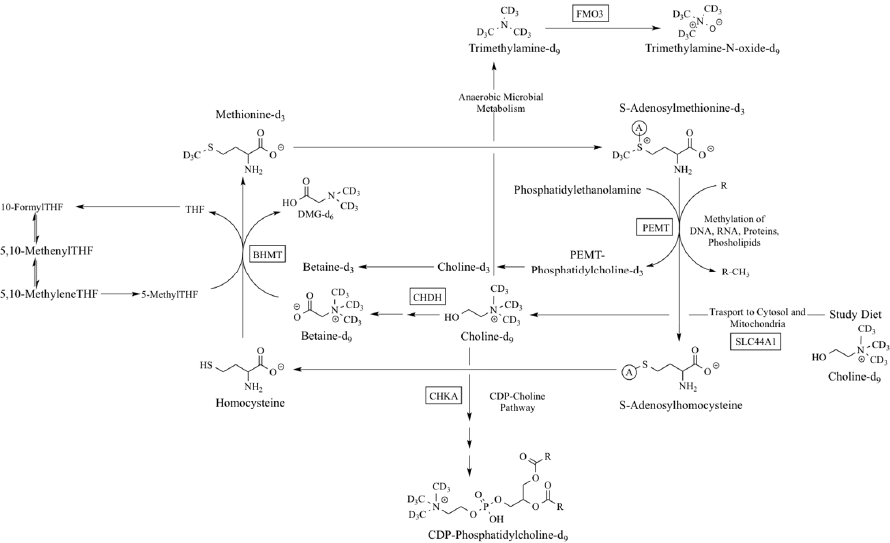
Figure 1. An overview of the metabolic fate of the isotopically labeled choline-d 9 consumed by study participants. SNPs in squared enzymes were examined. Choline kinase- α ( CHKA ) rs10791957; choline dehydrogenase ( CHDH ) rs9001, CHDH rs12676; betaine homocysteine methyltransferase ( BHMT ) rs3733890; phosphatidylethanolamine N -methyltransferase ( PEMT ) rs7946, PEMT rs4646343; solute carrier 44A1 ( SLC44A1) rs7873937, SLC44A1 rs3199966; and flavin monooxygenase isoform 3 ( FMO3) rs2266782).